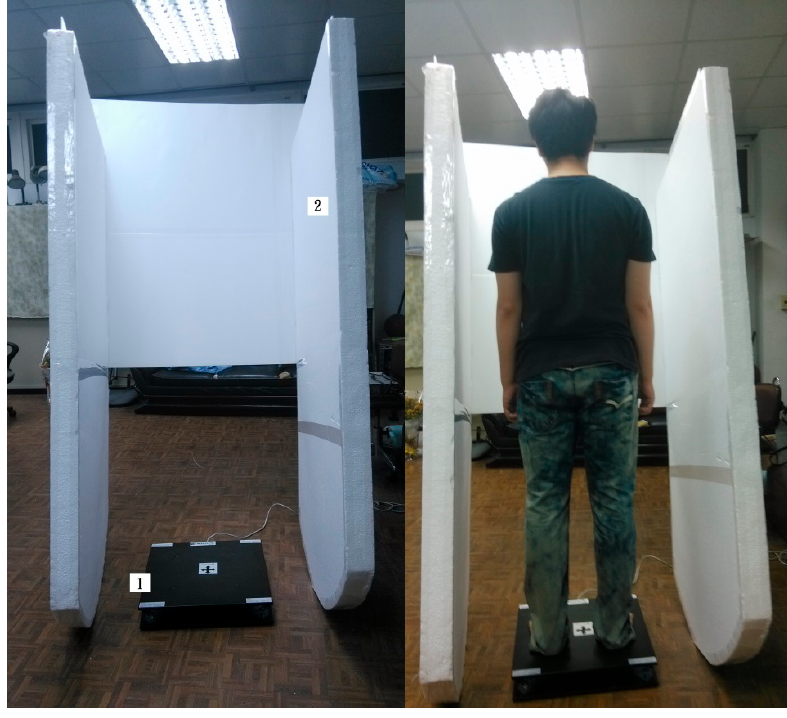
Figure 1. The facilities in the experiment design: ( 1 ) force plate, ( 2 ) referenced wall.